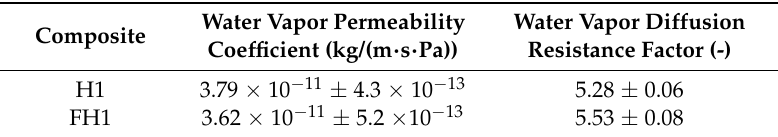
Table 2. Coefficient of water vapor permeability ( δ ) and factor of diffusion resistance ( µ ) of composites ( ±